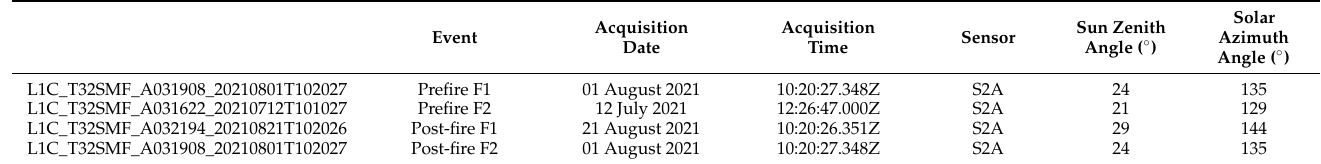
Table 2. Some characteristics of the Sentinel 2 images used in this study.